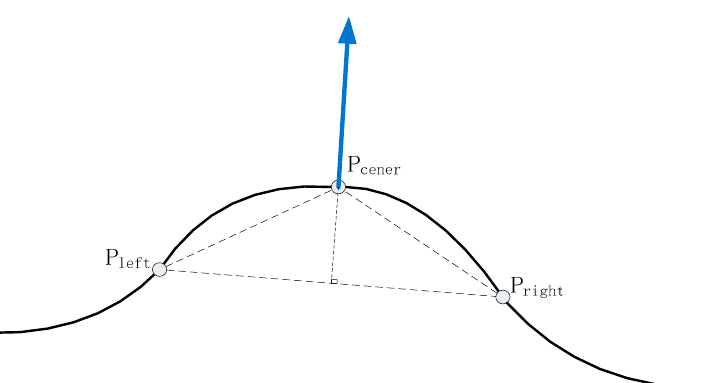
Figure 11. Computing the normal vector of a curve. P centre is the selected point, and V left and V right are adjacent points of the selected point. The blue arrow is the normal vector of the curve at P centre .